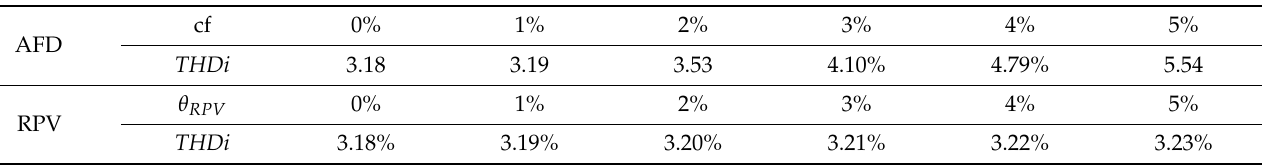
Figure 3. Voltage and current waveforms under AFD method: ( a ) cf = 0%, ( b ) cf = 1%, ( c ) cf = 2%, ( d ) cf = 3%, ( e ) cf = 4%, ( f ) cf = 5%. Table 5. Power quality comparison based on total harmonic distortion ( THDi ) under the AFD and RPV anti-islanding